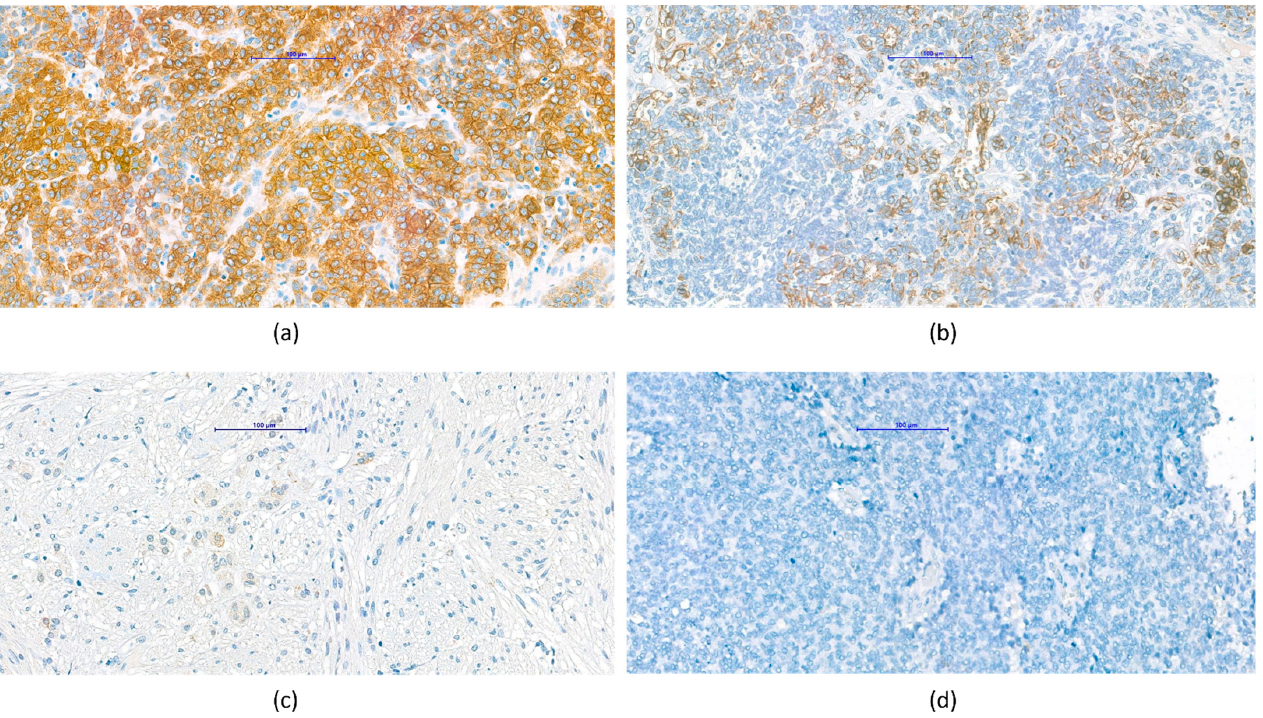
Figure 1. Representative vitamin D receptor (VDR) immunohistochemistry samples according to expression levels. Tumor cells showed membrane/cytoplasmic VDR expression, no nuclear positivity was observed; ( a ) score 3, high expression (VDR > 50%), ( b ) score 2, intermediate expression (10% < VDR < 50%), ( c ) score 1, low expression (VDR < 10%), ( d ) score 0, considered negative. Table 1. The table below shows the number of samples belonging to each VDR expression and the prognostic group. A significant association ( p = 0.0061) is described between lower VDR expression in tumor samples and poor outcomes. For the statistical analysis, tumor samples and the survival datasets of 110 children were available. Favorable Prognosis Unfavorable Prognosis Significant VDR